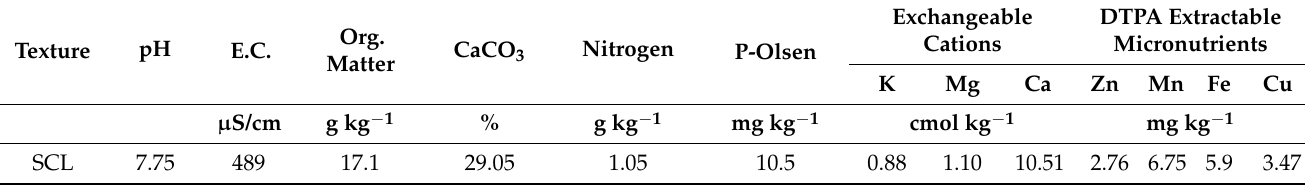
Table 4. Main soil